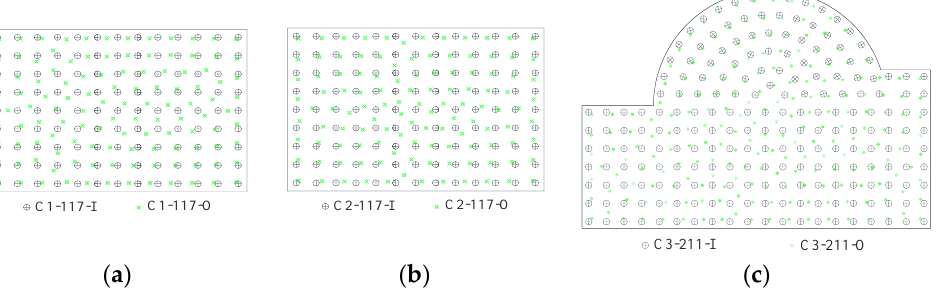
Figure 9. Pile arrangements of different models: ( a ) initial design (C1-117-I) and optimization design (C1-117-O) of Case 1; ( b ) initial design (C2-117-I) and optimization design (C2-117-O) of Case 2; ( c ) initial design (C3-211-I) and optimization design (C3-211-O) of Case 3.